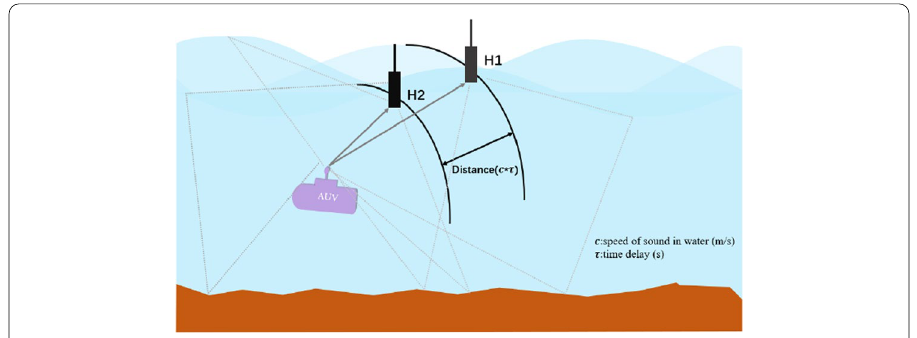
Fig. 5 Multipath